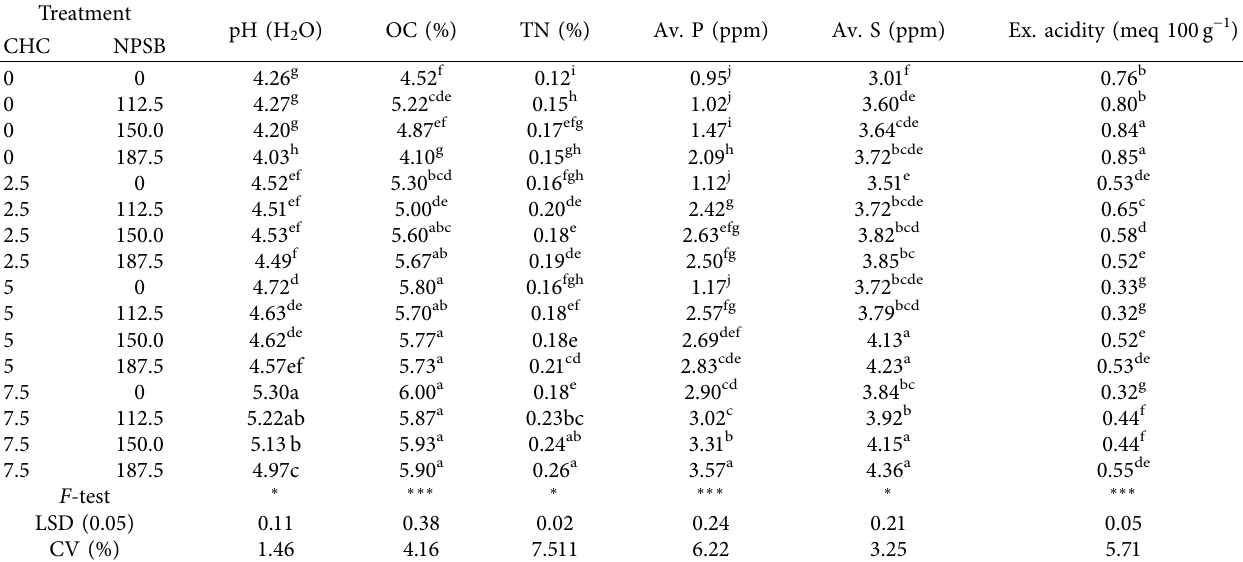
Table 3: Interaction effect of CHC and NPSB fertilizer on soil chemical properties of potato field soil.